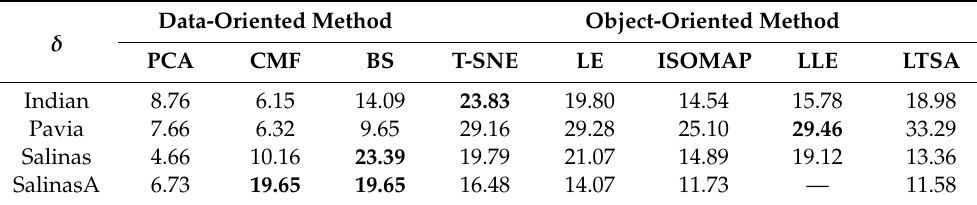
Table 3. Separability between pixels ( δ ).